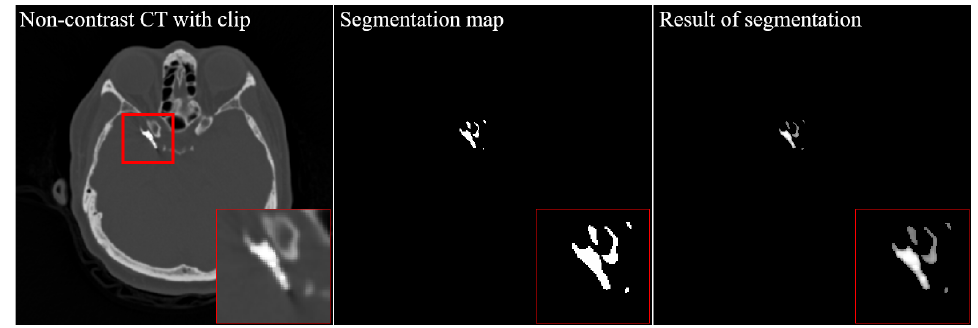
Figure 9. Segmentation of both metallic component and bone, which is very close to the target metal, using the proposed method.